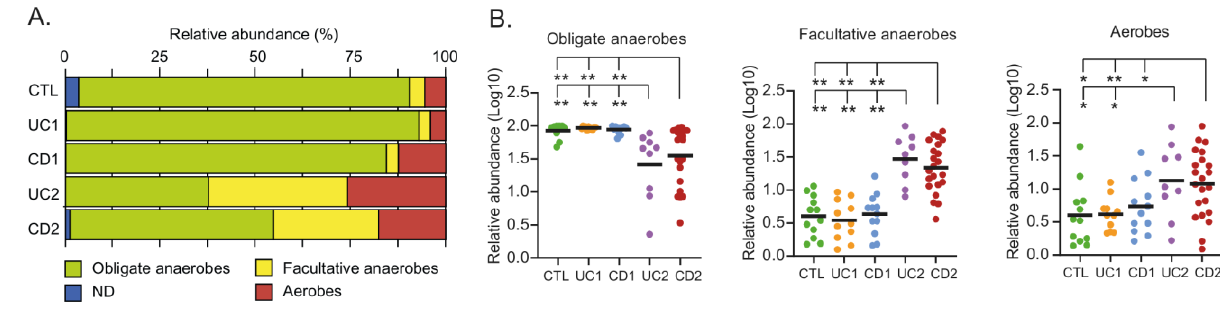
FIGURE 5: Microbial respiration of mucosa-associated intestinal microbiota among the IBD patients. (A) Relative abundances (%) of OPUs classified as obligate anaerobes, facultative anaerobes, or aerobes. (B) Differences in the relative abundances (Log10) of obligate anaerobes, facultative anaerobes, or aerobes . Each data point corresponds to a sample and horizontal lines to the means. Significance: * p < 0.05, ** p < 0.005, Kruskal- Wallis & Dunn’s tests. ND: Unclassified bacteria with unknown respiration